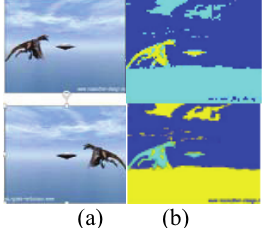
Fig. 5.4. (a) Keyframes and their corresponding (b) clustered frames